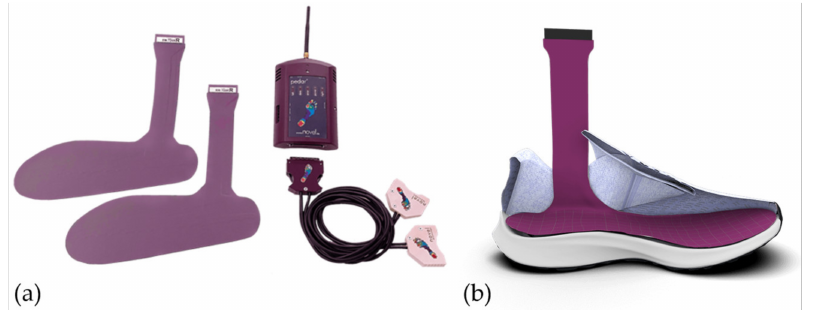
Figure 1. Novel ® Pedar™ pressure insole system. ( a ) Complete system ( b ) Pedar insole positioned within an insole (taken from https://www.novel.de/products/pedar/ accessed on 15 January